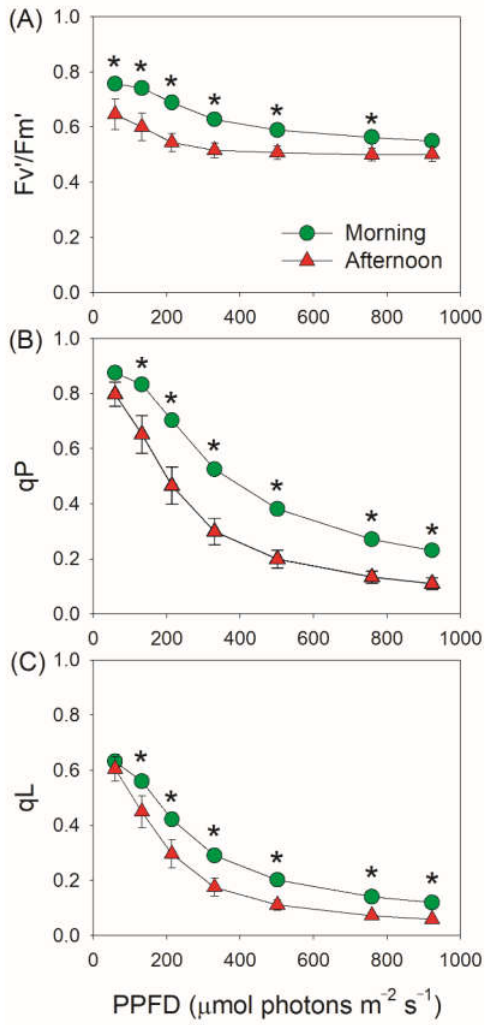
Figure 2. Light intensity dependence of F v ′/ F m ′ ( A ), qP ( B ) and qL ( C ) for leaves of Vanilla planifolia measured in the morning and in the afternoon. F v ′/ F m ′, the maximum efficiency of the open PSII centers in the light; qP, coefficient of photochemical quenching based on the “puddle model” of PSII; qL, coefficient of photochemical quenching based on the “lake model” of PSII. Data are means ± SE ( n = 5). Asterisk indicates a significant difference between morning and afternoon.